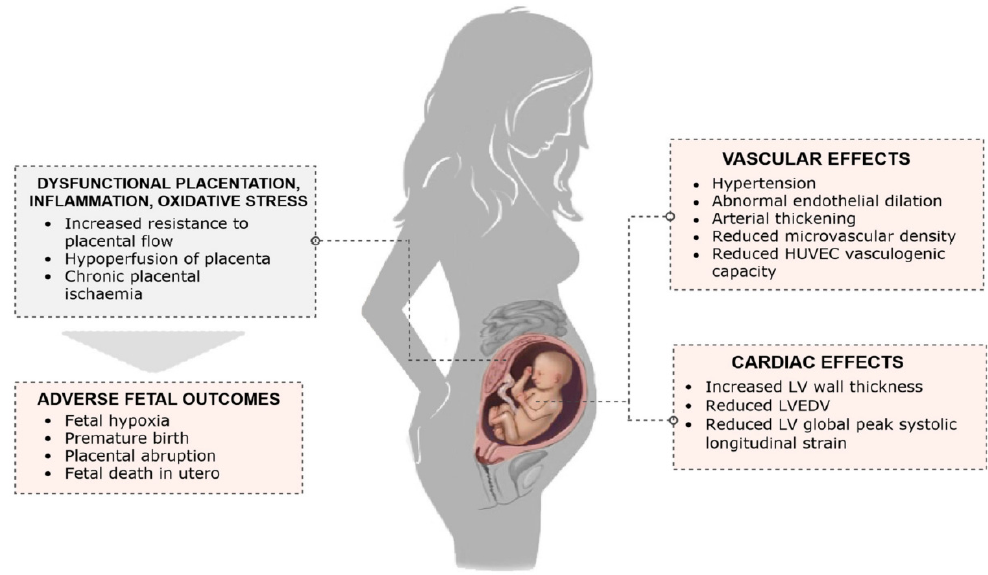
Figure 2. Effects of Preeclampsia on the fetus. HUVEC stands for human umbilical vein. ED; LV, left ventricle; LVEDV, left ventricular end-diastolic volume. Reproduced with permission from: Fox et al., 2019.